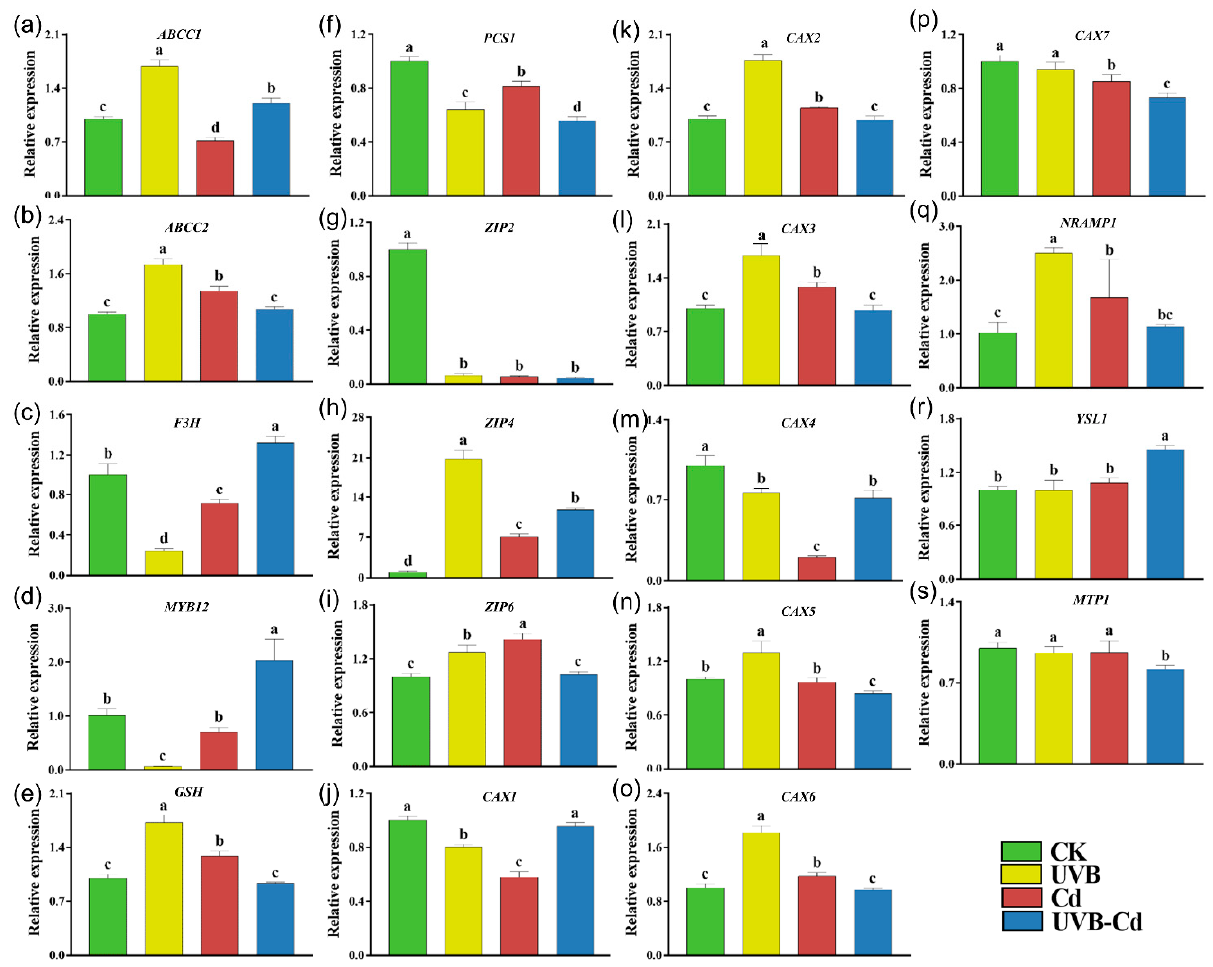
Figure 6. Relative expression of genes related to Cd uptake, transport, and detoxification in poplar leaf under different treatments. The expression levels of ABCC1 ( a ), ABCC2 ( b ), F3H ( c ), MYB12 ( d ), GSH ( e ), PCS1 ( f ), ZIP2 ( g ), ZIP4 ( h ), ZIP6 ( i ), CAX1 ( j ), CAX2 ( k ), CAX3 ( l ), CAX4 ( m ), CAX5 ( n ), CAX6 ( o ), CAX7 ( p ), NRAMP1 ( q ), YSL1 ( r ), and MTP1 ( s ) in poplar leaf ( n = 5 plants for each treatment). Different letters represent significant differences among four treatment groups ( p < 0.05).